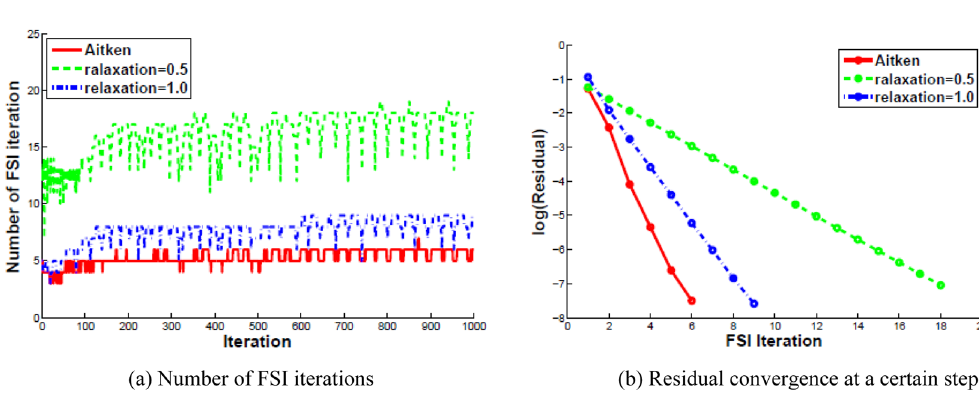
Figure 10. Comparison of Convergence rate with different relaxation